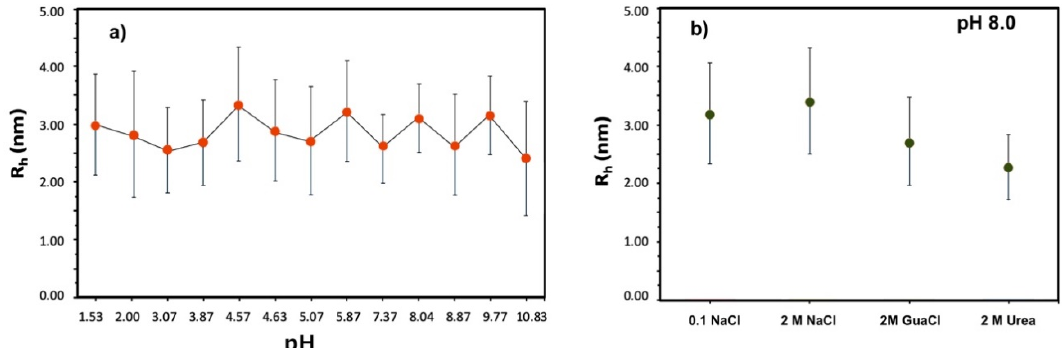
Figure 2. Dependence of M- l -Gln hydrodynamic radius, R h , on: ( a ) pH (in 0.1 M NaCl); ( b ) ionic strength (in 2 M NaCl) and denaturing agents (guanidinium chloride, GuaCl, and urea). Data obtained by DLS at 25 °C on 1 mg mL − 1 solutions.